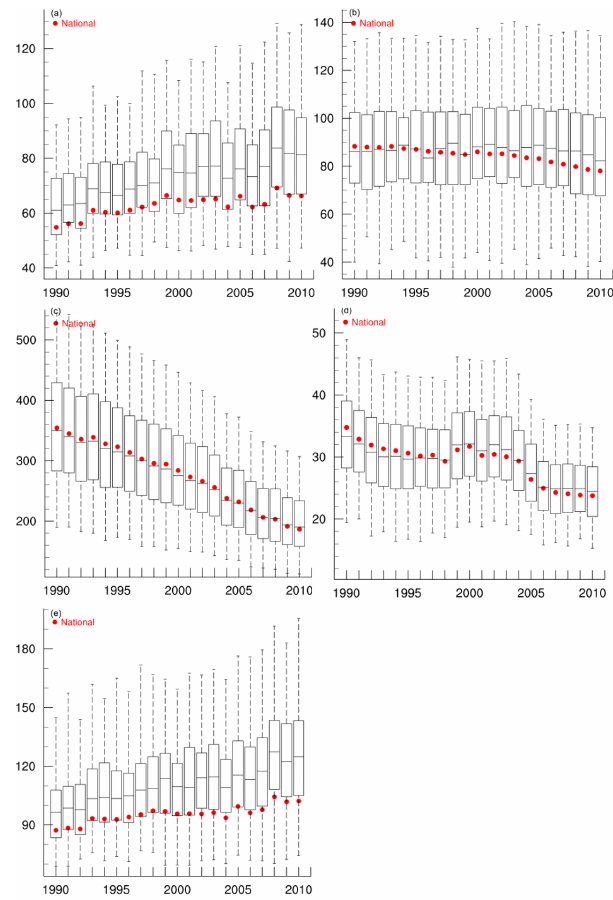
Figure 5. The baseline mortality rates for specific causes of death related to PM 2 . 5 , including chronic obstructive pulmonary dis- ease (a) , lung cancer (b) , ischemic heart disease (c) and stroke (d) , and respiratory diseases related to O 3 (e) . The bottom whiskers, bot- tom border, middle line, top border and top whiskers of the boxes indicate the 5th, 25th, 50th, 75th, and 95th percentiles, respectively, across all counties; the red circles are the national average rate. Baseline mortality rates are shown for 1990–1998 after they are corrected to ensure comparability between ICD9 and ICD10 codes. The units on the y axis are per 100000